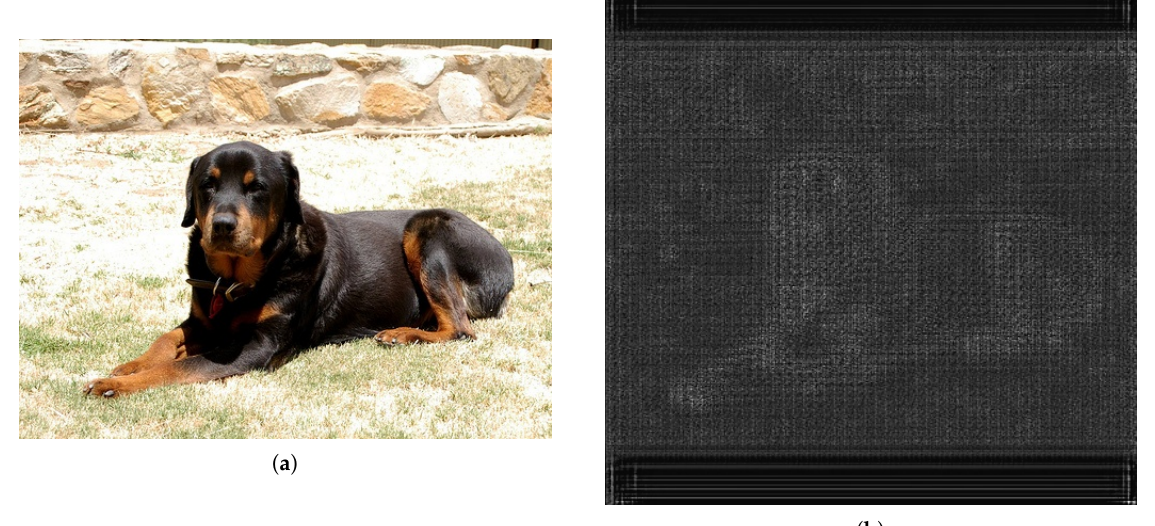
Figure 5. ( a ) Input image and ( b ) a visualized example of an auto-tiled feature